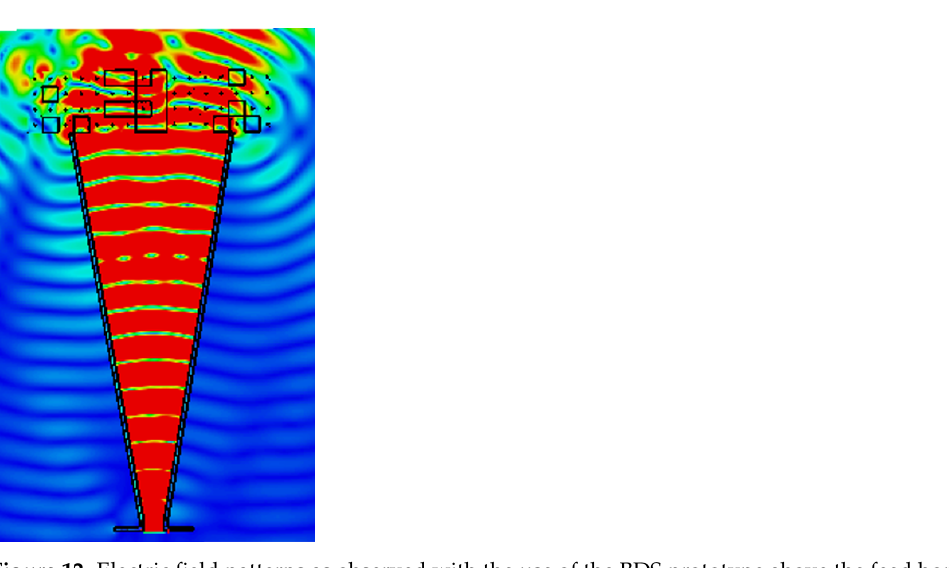
Figure 12. Electric field patterns as observed with the use of the BDS prototype above the feed